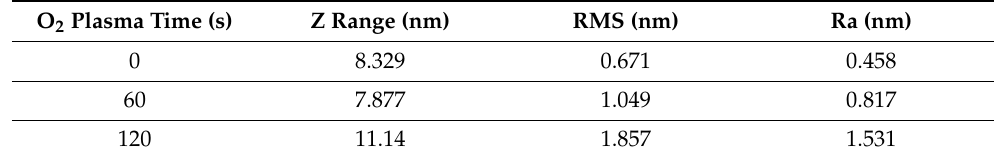
Figure 2. AFM surface morphology characterization of the a-IGZO films at the O 2 plasma times of ( a ) 0, ( b ) 60, and ( c ) 120 s. Table 1. Z range, root mean square (RMS) roughness, and average roughness (Ra) of the a-IGZO films at various O 2 plasma times.